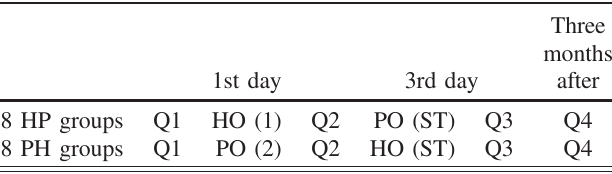
TABLE I. Chronology of activities in human Orrery and printed Orrery and questionnaires. Activities were led by the first author (1), the second author (2) or a school teacher